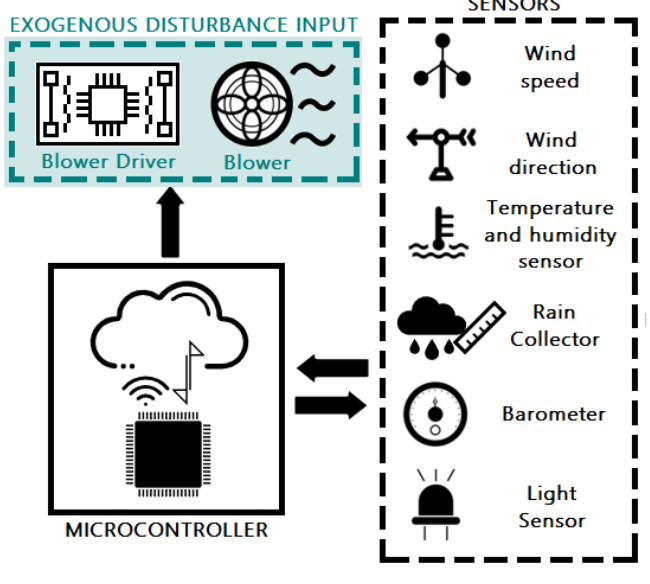
Figure 8. MEIoT weather station with exogenous disturbance input